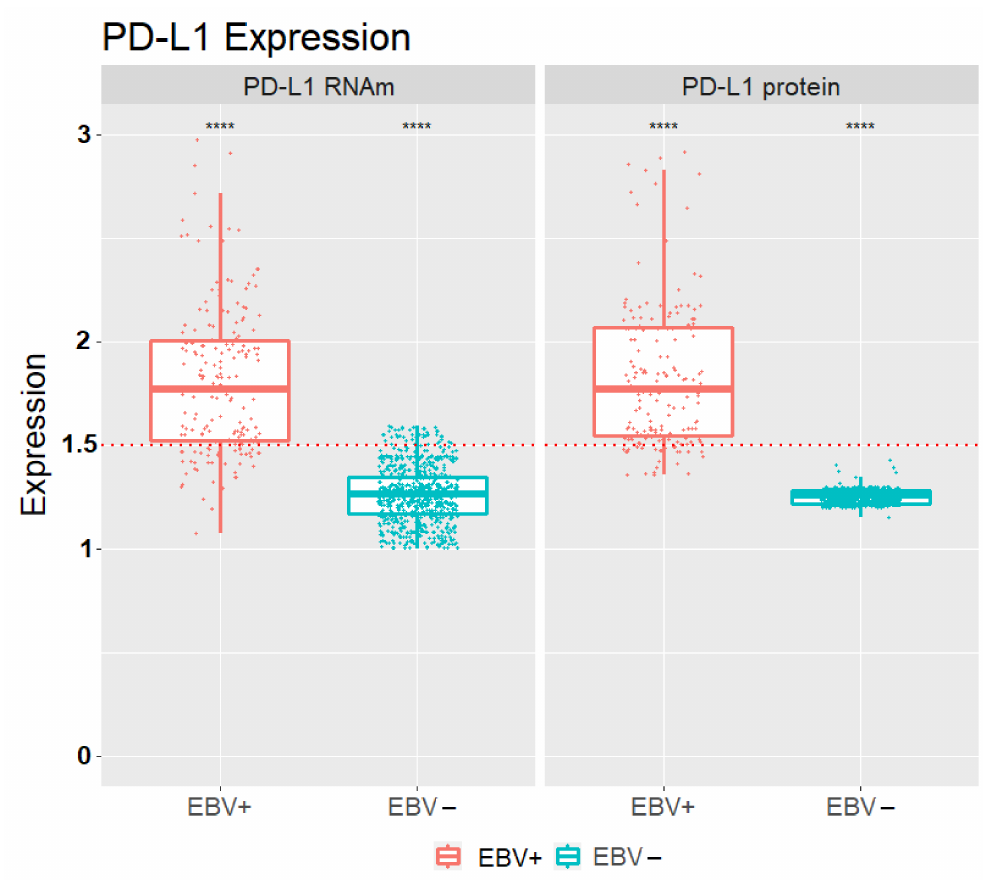
Figure 1. PD-L1 mRNA level expression in patients with positive and EBV-negative status. (**** p < 0.0001). The red dotted lines represent the 1.5-fold